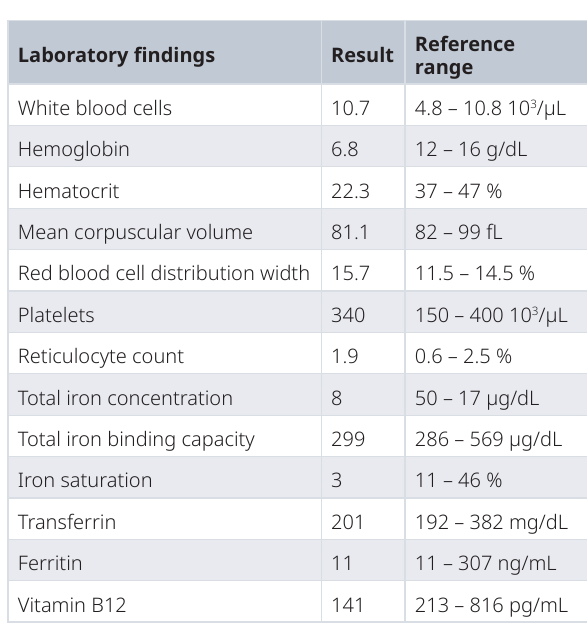
Table 1. Biochemical analysis reveals an anemia. Corrected reticulocyte count and reticulocyte index for her age and gender suggests an inappropriate marrow response (reticulocyte index < 2) likely relating to the patient’s nutritional deficiencies, instead of bone marrow abnormalities. The low vitamin B12 level supports the lack of sufficient vitamin B12 in the blood. Serum IF-blocking antibody testing was not obtained on admission, but after EGD, which was positive and confirmed the diagnosis